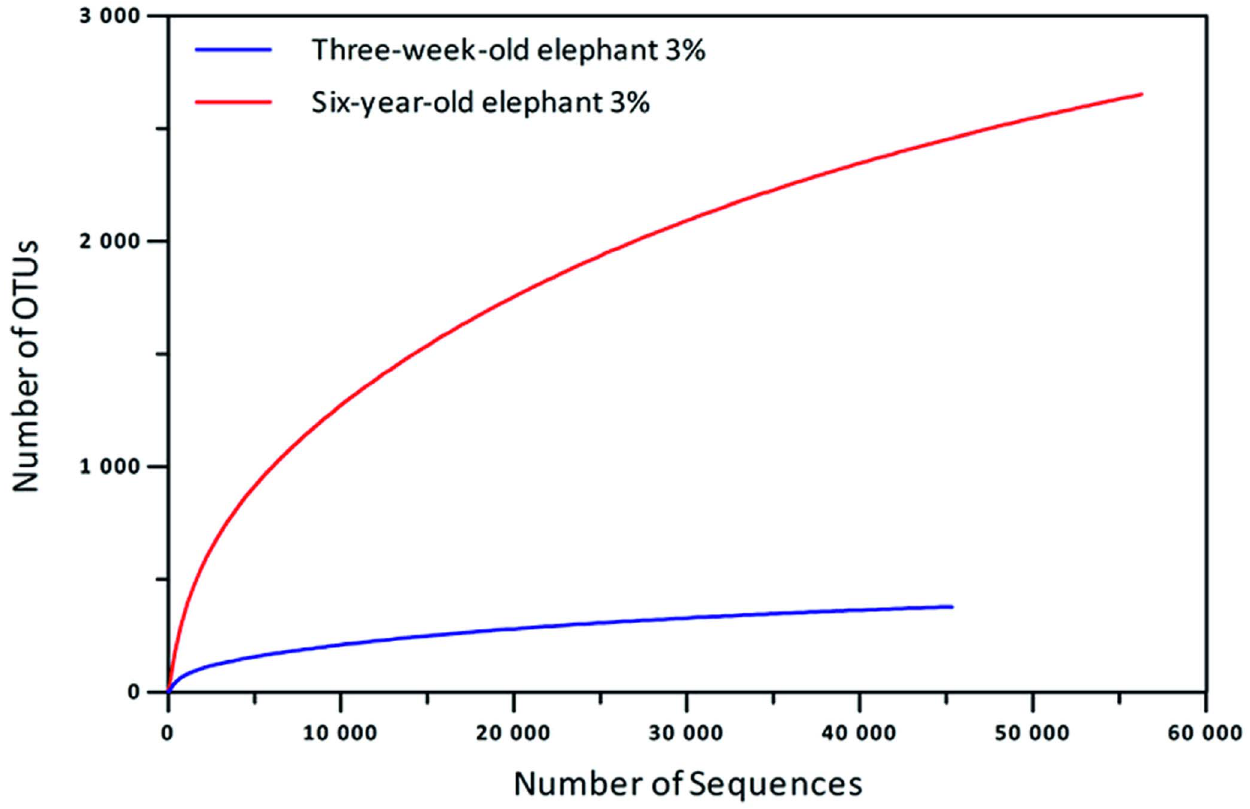
Figure 1. Rarefaction curves calculated for the feces sample of the three-weeks-old and the six-years-old Asian elephant at 3% genetic distance of 16S rRNA genes. The curve for the six-years-old elephant comprises 8,014 archaeal sequences which were clustered to 54 OTUs. The sequences were denoised employing Acacia. Chimeric sequences were removed using UCHIME in reference mode with the most recent SILVA SSU database as reference dataset (SSURef 115 NR).